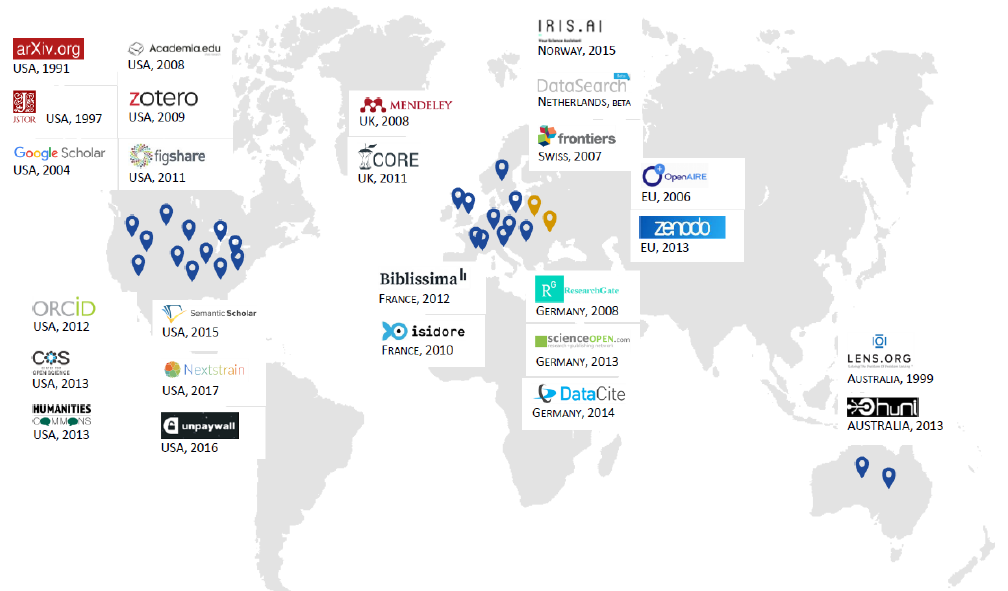
Fig 3: Overview of analysed platforms including location information and launch